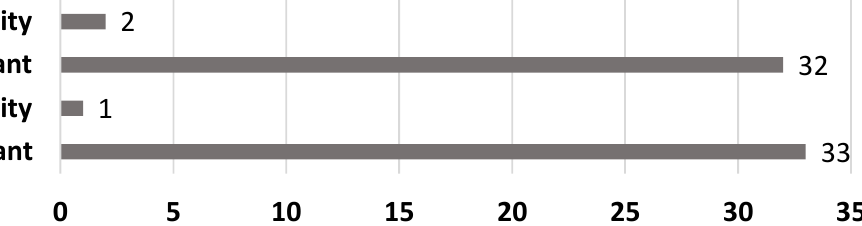
Figure 3. Feature level differences in metataxonomics dominated by individual differences. ( a – d ) Top-ranked OTU level differences based on FDR corrected p value across sample types and activ- ity/participant differences labelled by lowest taxonomic classification achieved, and ( e ) total number of significantly different OTU features across sample types and activity/participant differences, with FDR-corrected p value below 0.05.